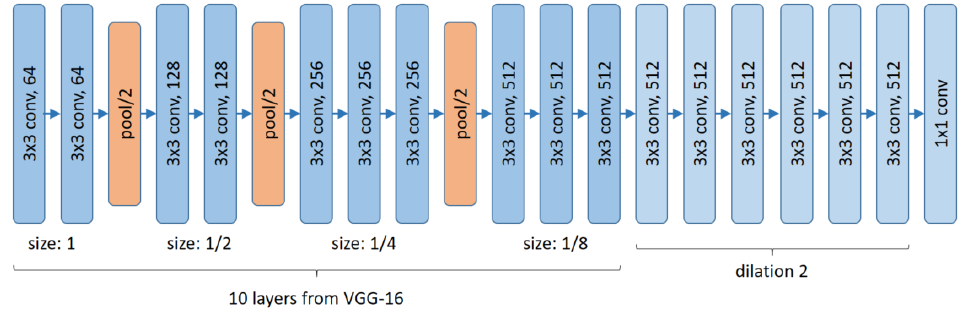
Figure 6. Architecture of Congested Scene Recognition Network (CSRNet) [9].